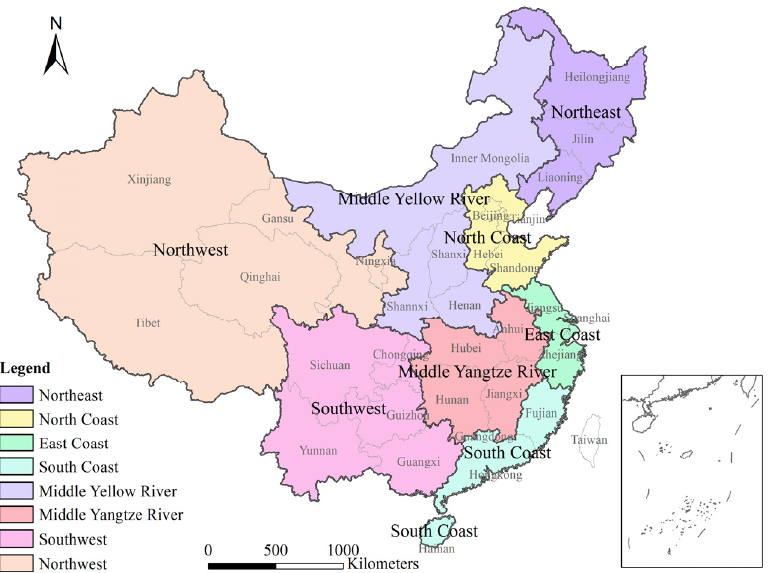
Figure 2. Eight-region division of the study area.